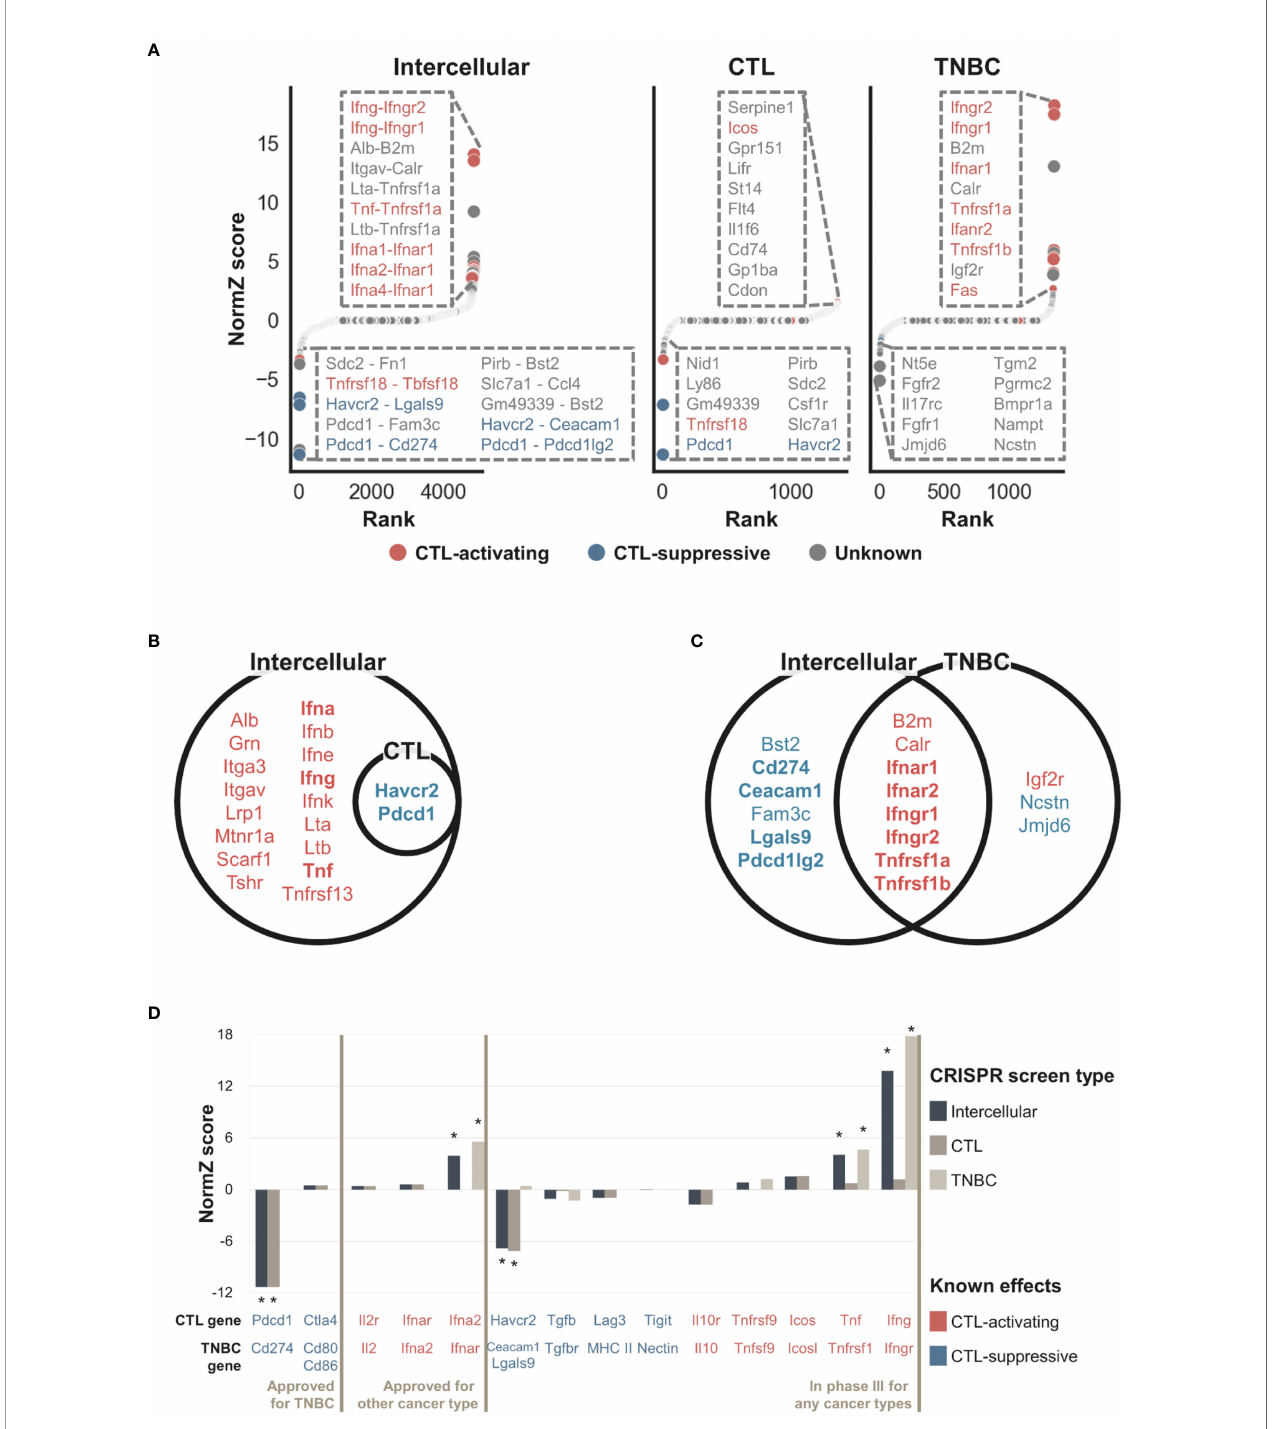
FIGURE 3 | NormZ scores from the intercellular, CTL, and TNBC CRISPR screens. Intercellular normZ scores were calculated by the ‘ Tolerant ’ method. (A) Rank- ordered normZ scores from the intercellular (left), CTL (middle), and TNBC (right) CRISPR screens. Interactions/genes known to activate and suppress CTL function are marked in red and blue, respectively. The dot sizes are negatively proportional to the FDR. The top ten interactions/genes are represented in the inset. (B) Statistically signi fi cant (FDR < 5%) genes from the gene-level intercellular and CTL CRISPR screens. (C) Statistically signi fi cant (FDR < 5%) genes from the gene-level intercellular and TNBC CRISPR screens. Genes with positive and negative normZ scores are marked with red and blue, respectively. Well-known immunomodulators from the silver standard data are marked in bold. (D) The intercellular, CTL, and TNBC normZ scores of interactions/genes targeted by approved immunotherapeutic drugs, or phase